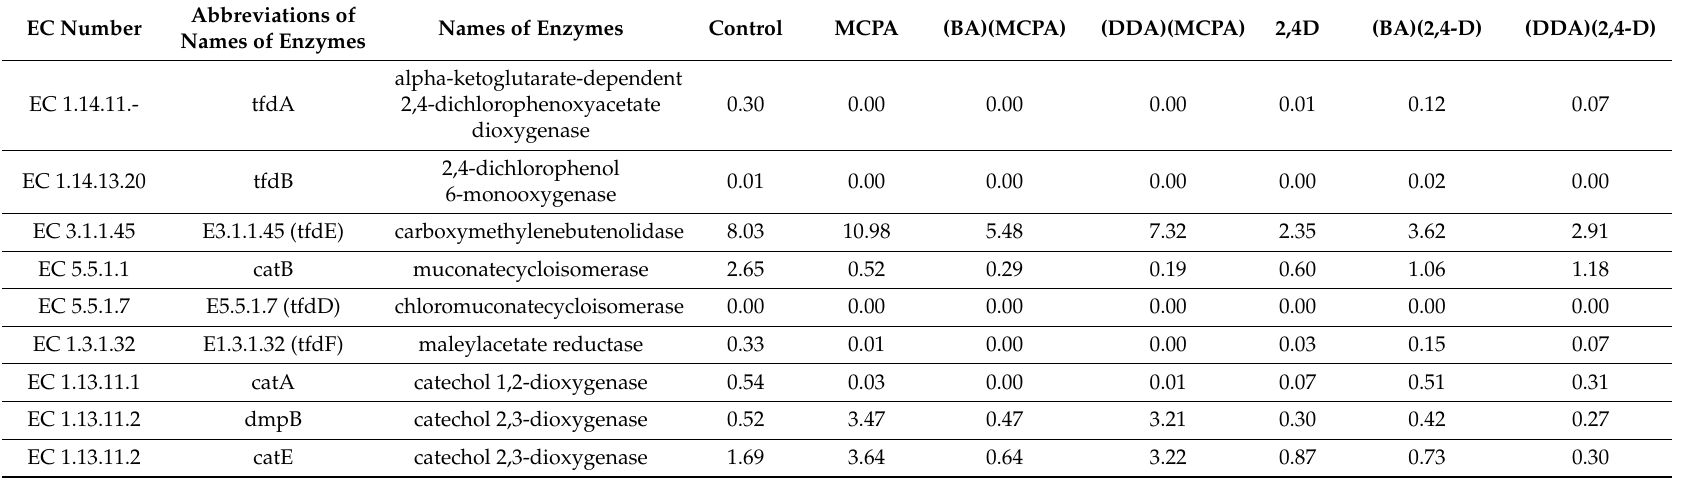
Table 5. Relative abundance of predicted metagenome